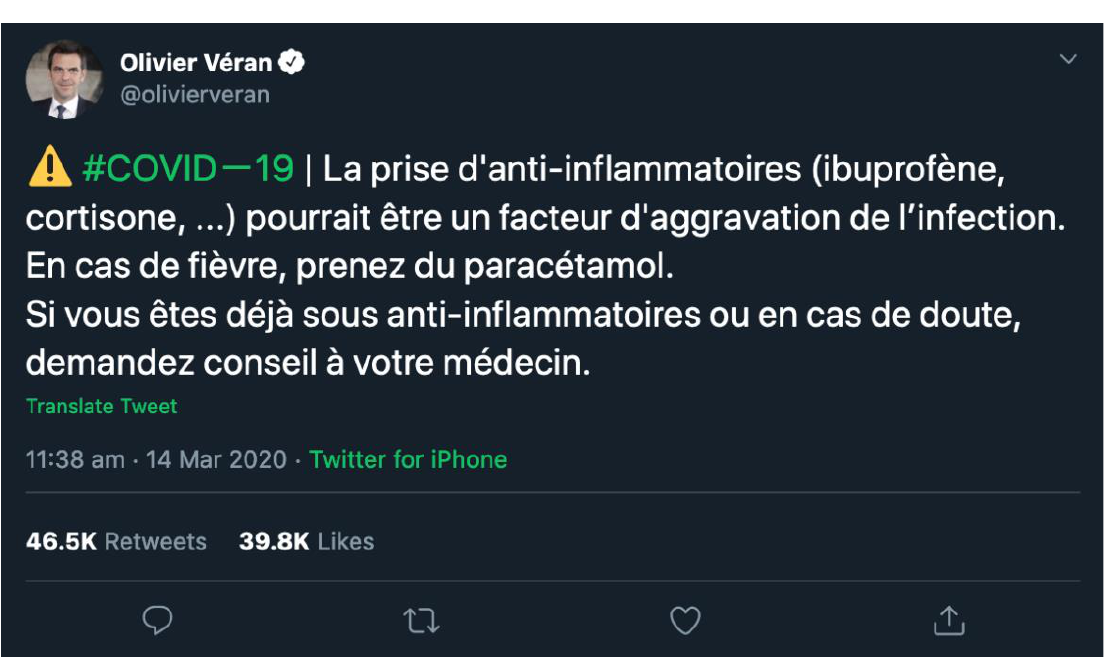
Figure 1. French health minister, Olivier Veran, tweet against ibuprofen (ibuprofène). Tweet translation: taking anti- inflammatory drugs (ibuprofen, cortisone, ...) could be a factor in aggravating the infection. In case of fever, take paracetamol. If you are already taking anti-inflammatory drugs or in case of doubt, ask your doctor for